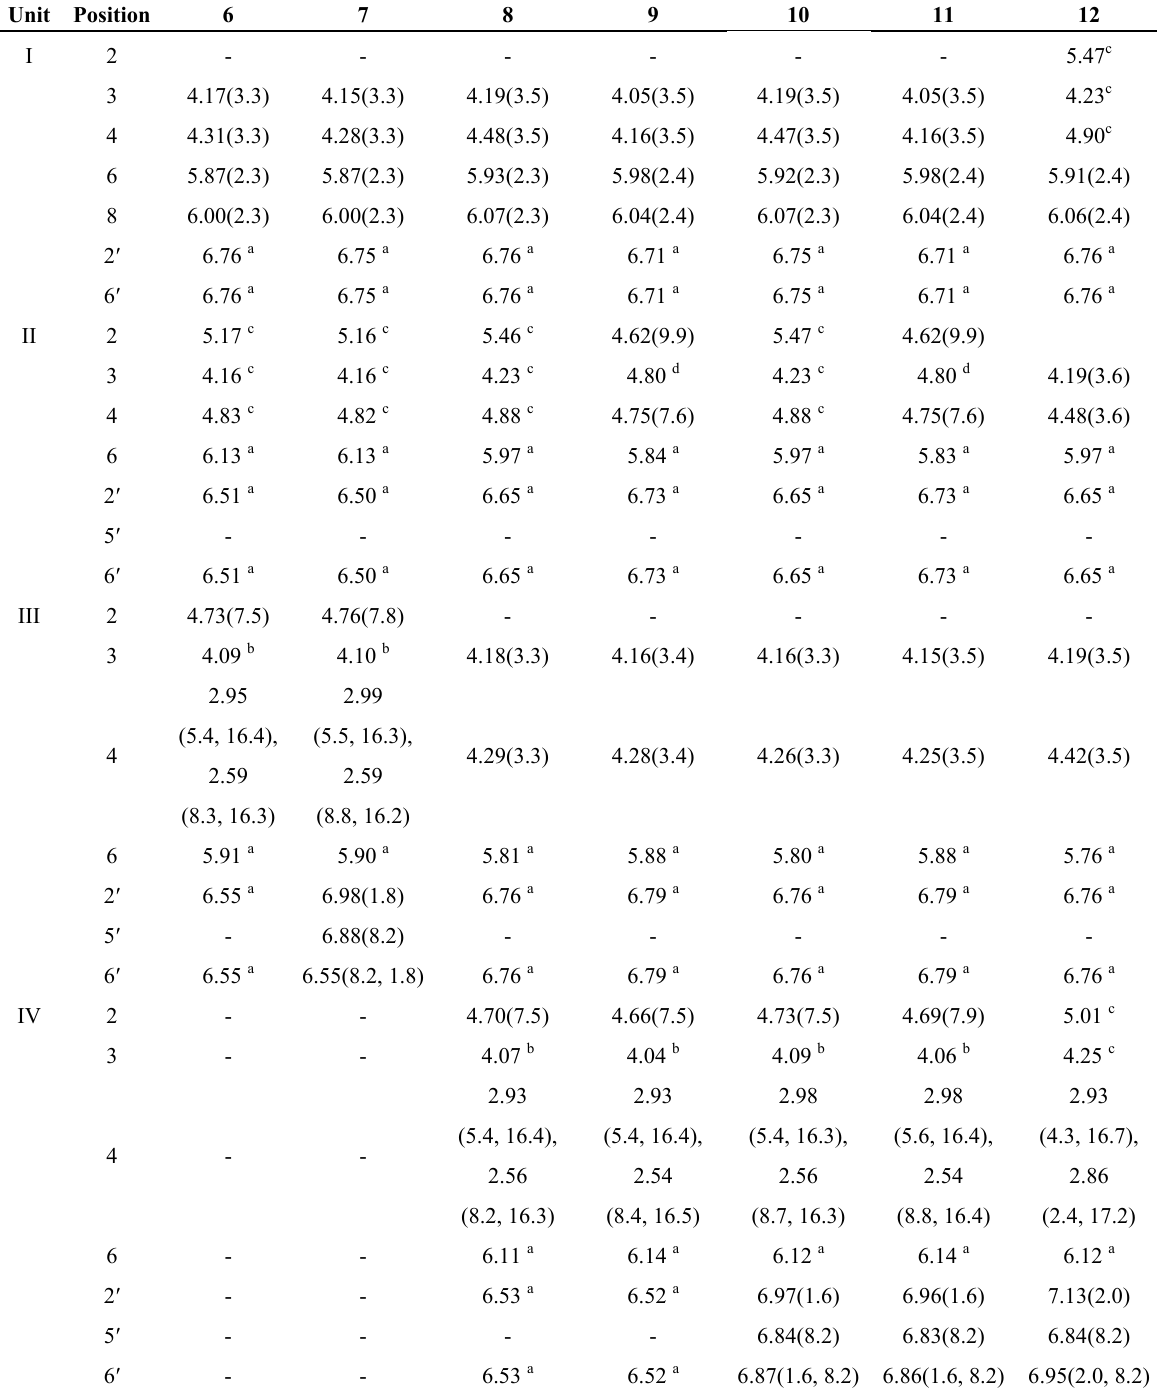
OD, δ in ppm, J in Hz). 3